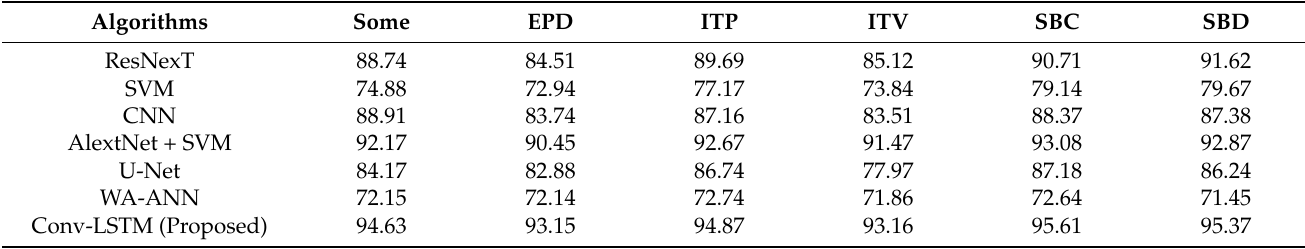
Table 8. Comparison of classification F1 score achieved by proposed technique and other compared